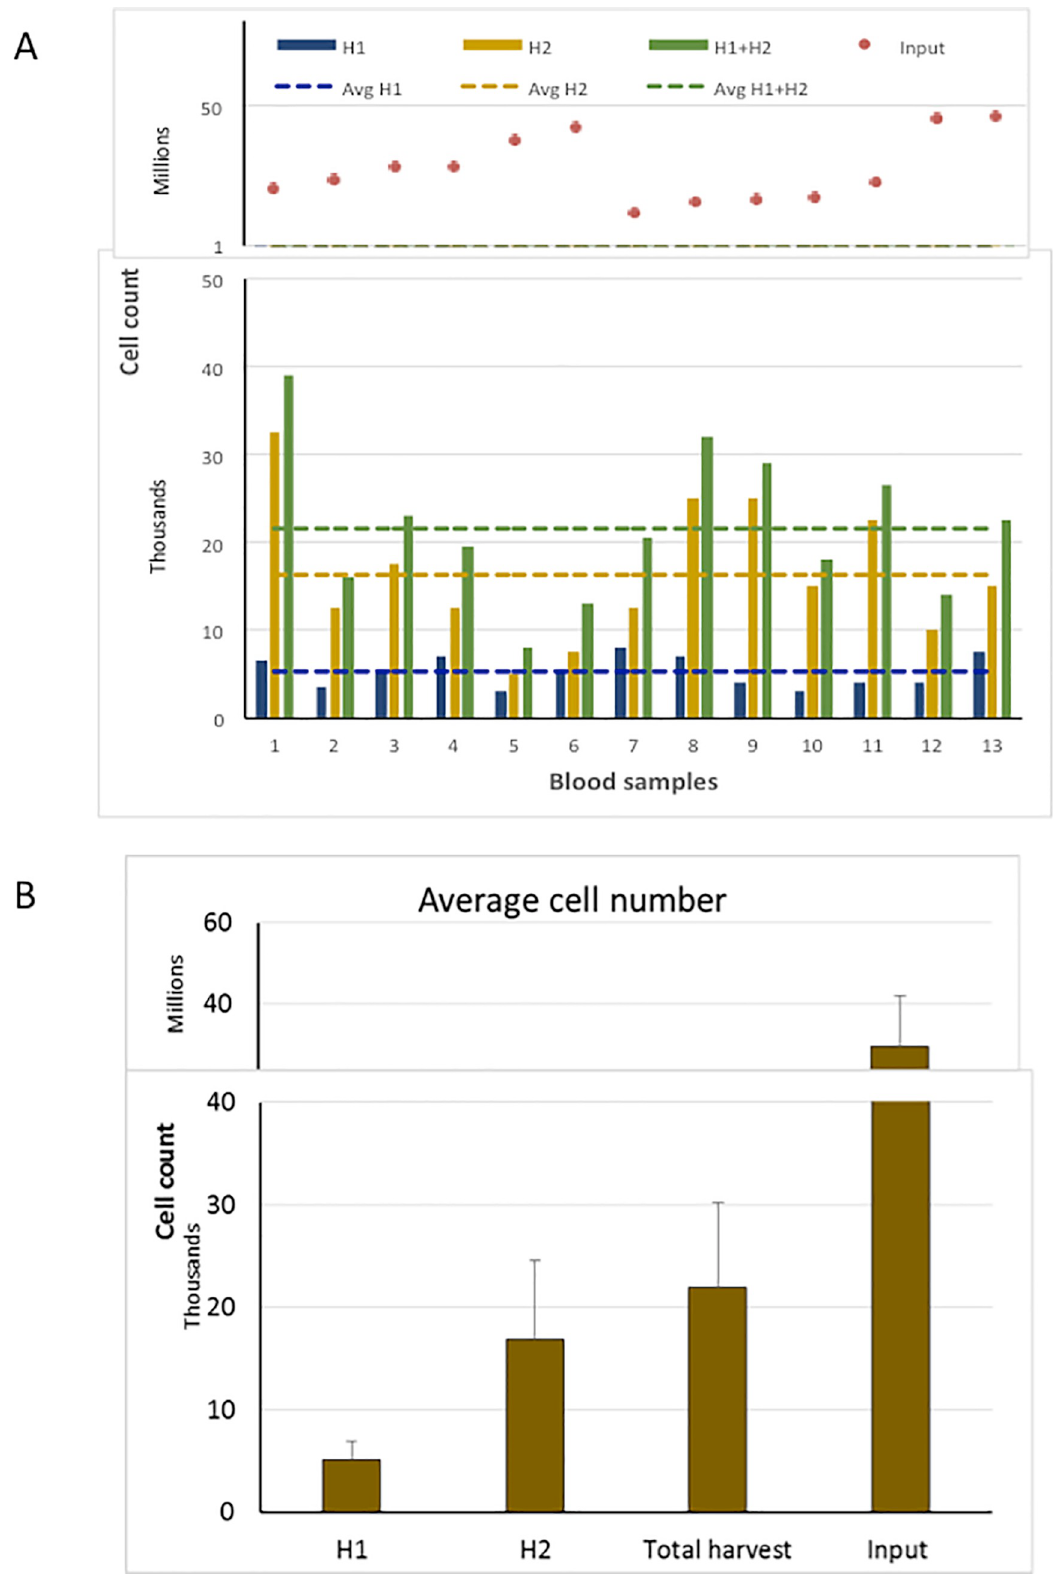
Fig 3. Yield of nucleated blood cells from patients with early stage breast cancer using Parsortix system.